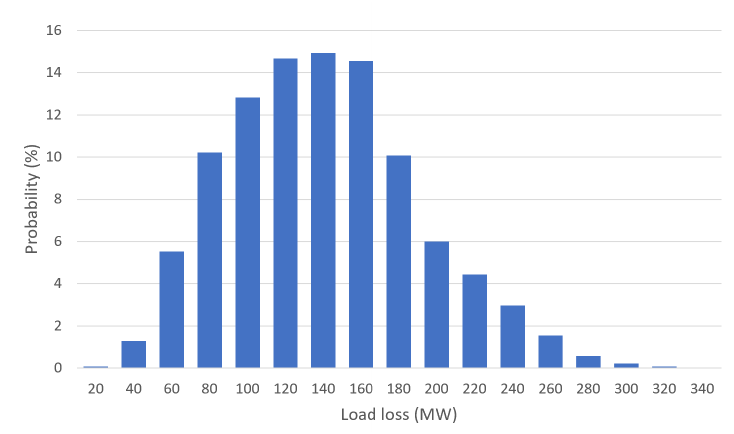
Figure 6. Load loss probability distribution (Peak load = 3156.97